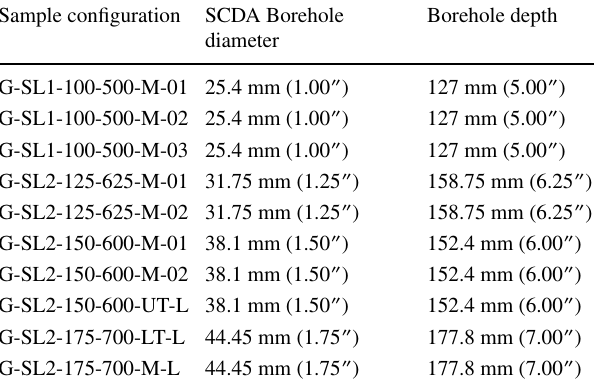
Table 1 Description of tested specimens